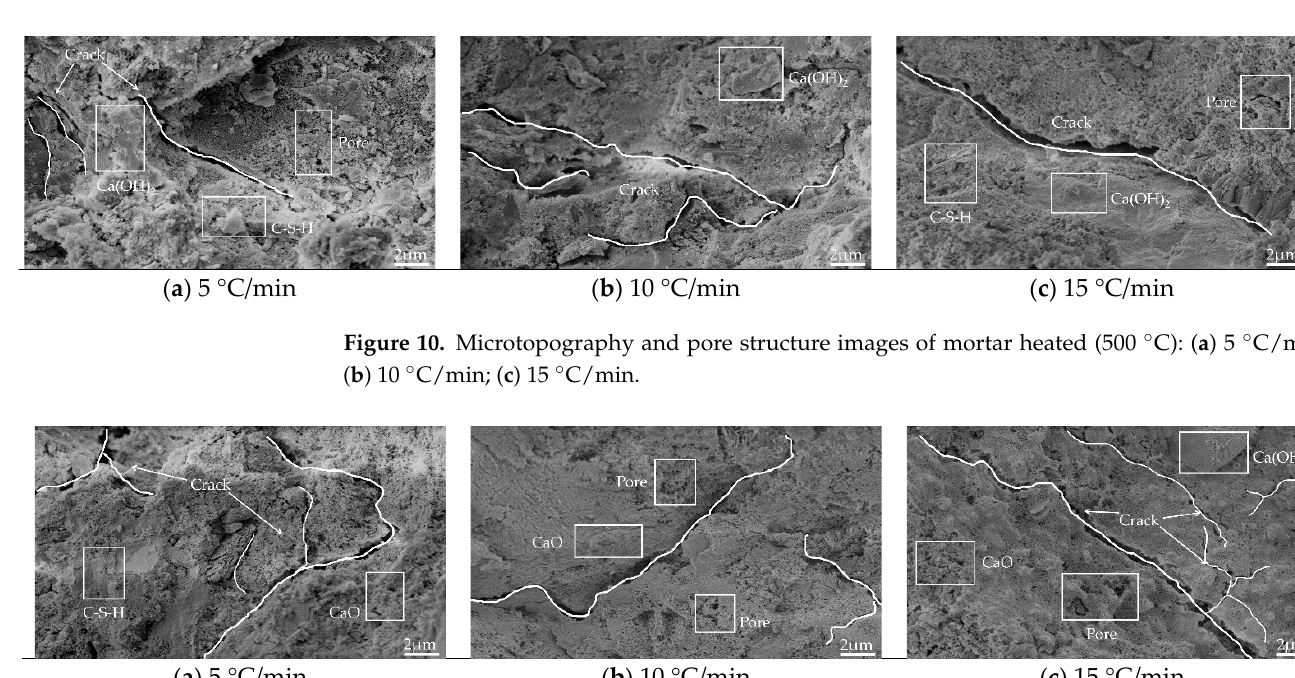
Figure 9. Microtopography and pore structure images of mortar heated (400 °C): ( a ) 5 °C/min; ( b ) 10 °C/min; ( c ) 15 °C/min.